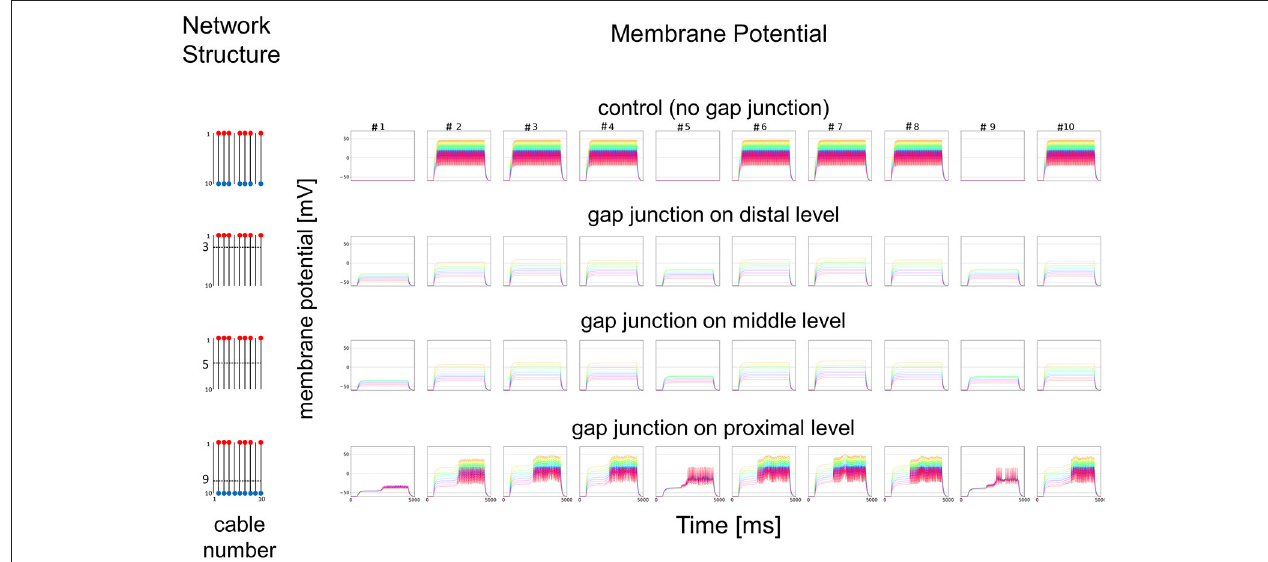
FIGURE 7 | Simplified model and functional simulation with a strong stimulation. Simulation results using multi-compartment model consisting of ten cables with mutual connections via GJs. Left , Network structure used in simulations. Four cases with different patterns of GJs are considered (no GJs, GJs at distal, middle, and proximal levels). Horizontal broken lines in network structure indicate electric connections between different cables via GJs. Red and blue dots indicate cables being given inputs and generating impulse outputs, respectively. Right , Spatiotemporal responses obtained from simulation. Each row shows time courses of membrane potentials for corresponding network structure. Membrane responses at 10 different compartments in each cable are shown by colored solid lines in each subfigure. Ten differently colored solid lines (orange, yellow, chartreuse, green, cyan, azure, blue, purple, pink, and red line) show time courses of membrane potentials at corresponding compartments (compartments 1–10), respectively. Namely, orange line corresponds to the compartment at the most distal level where input is given, while red line corresponds to the compartment at the most proximal level where impulse generating mechanism is assumed.